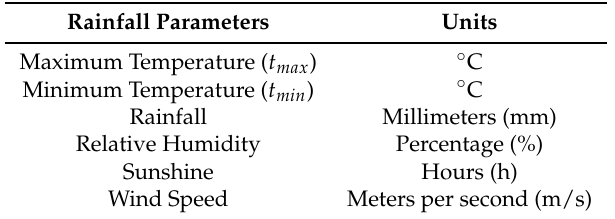
Figure 2. Map of Bhutan showing major river basins and the annual precipitation (mm). The study area is indicated in the legend. Table 2. The parameters used in our study and their corresponding